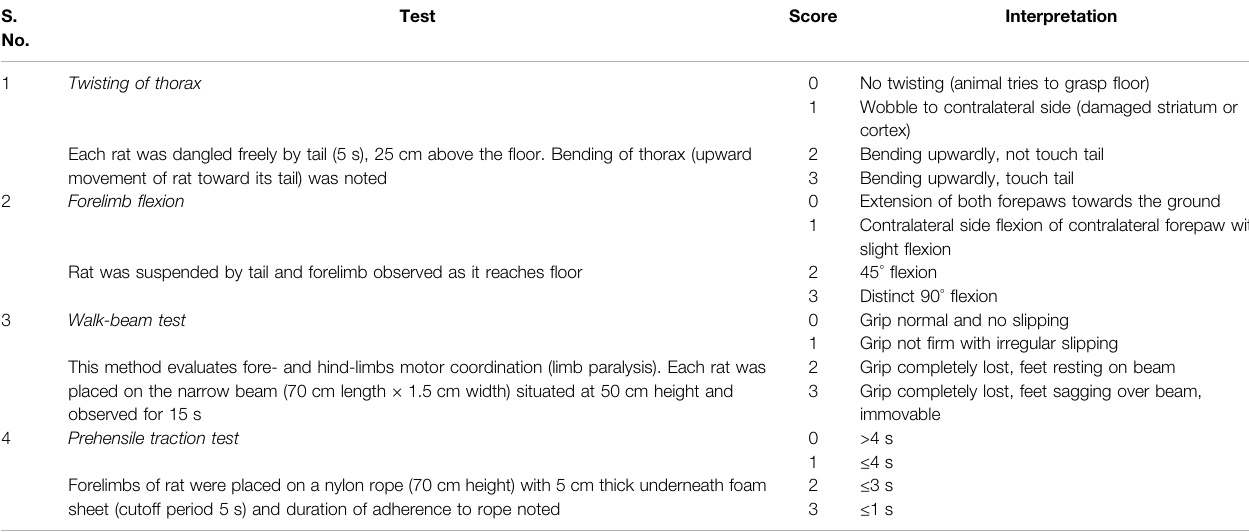
TABLE 1 | Scoring scale (12-point) for modi fi ed neurological severity score test (mNSS) in rats. Each animal was exposed to four different tests (twisting of thorax, forelimb fl exion, beam-walk test, and hanging-wire test) and scores added to obtain neurological de fi cit score (NDS) of an individual animal. S.